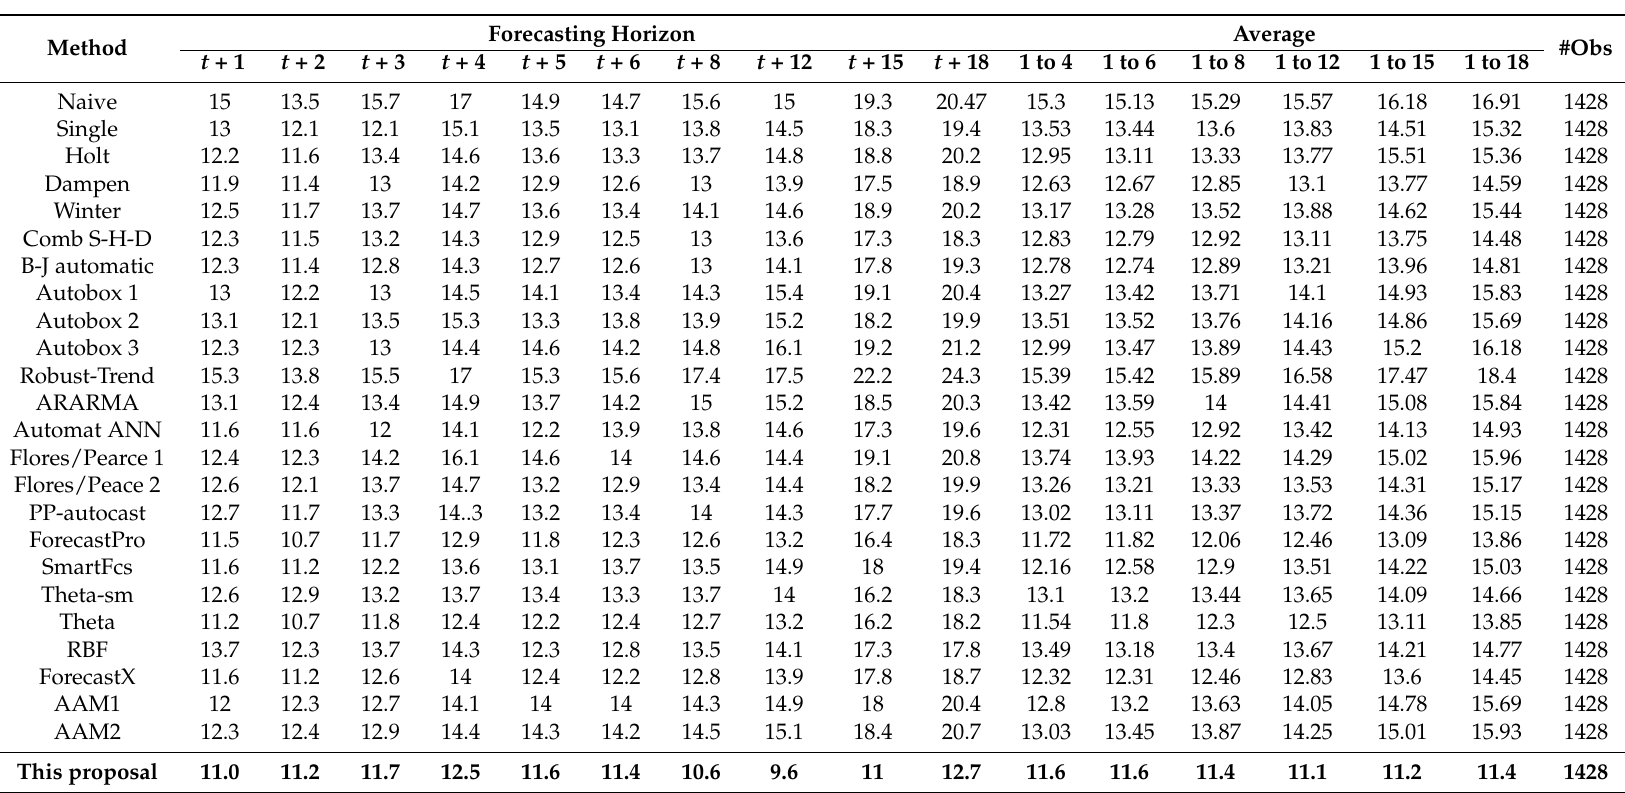
Table 7. SMAPE on M3-Competition for Monthly